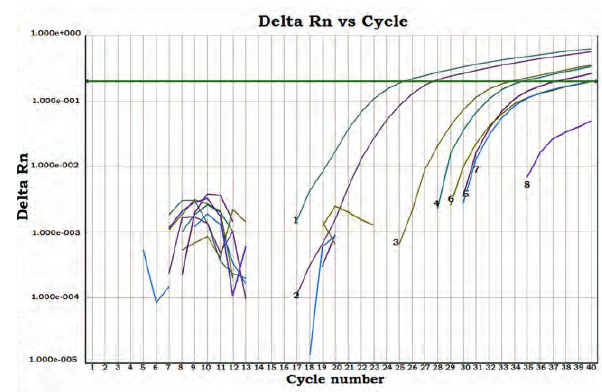
Figure-3. Real-Time RT-PCR threshold curves and limit of detection of isolate KMNO4 in 10 fold dilution Label: 1-70pg; 2- 7.0pg; 3-0.7pg; 4-0.07pg; 5-7.0 pg; 6-0.7fg; 7-0.07fg and 8- NTC. The number 1- 10 indicates the 10 fold (10-1 to 10-7) dilution of the